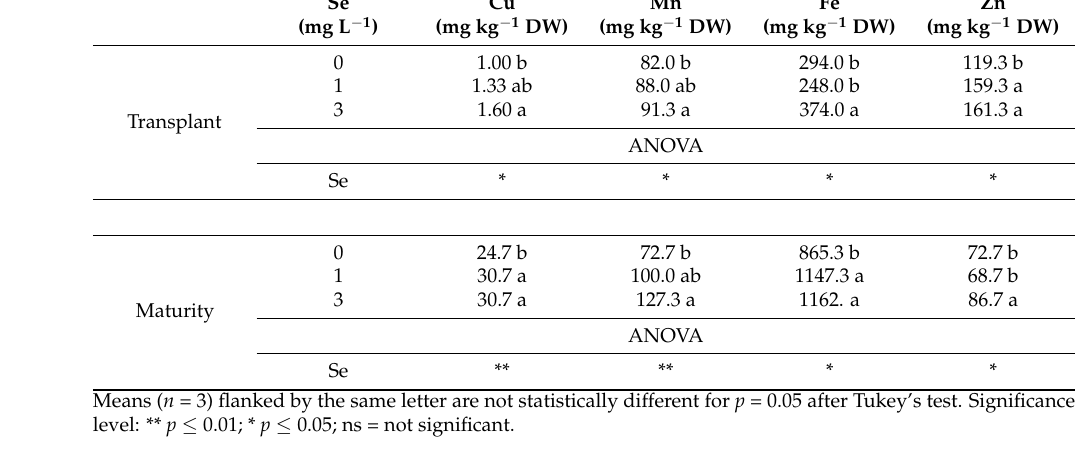
Table 3. Copper (Cu), manganese (Mn), iron (Fe) and zinc (Zn) content, measured at transplant and at maturity, in basil plants treated with different concentrations of Se at pre-transplanting. Se Cu Mn (mg L − 1 ) (mg kg − 1 DW) (mg kg − 1 DW)